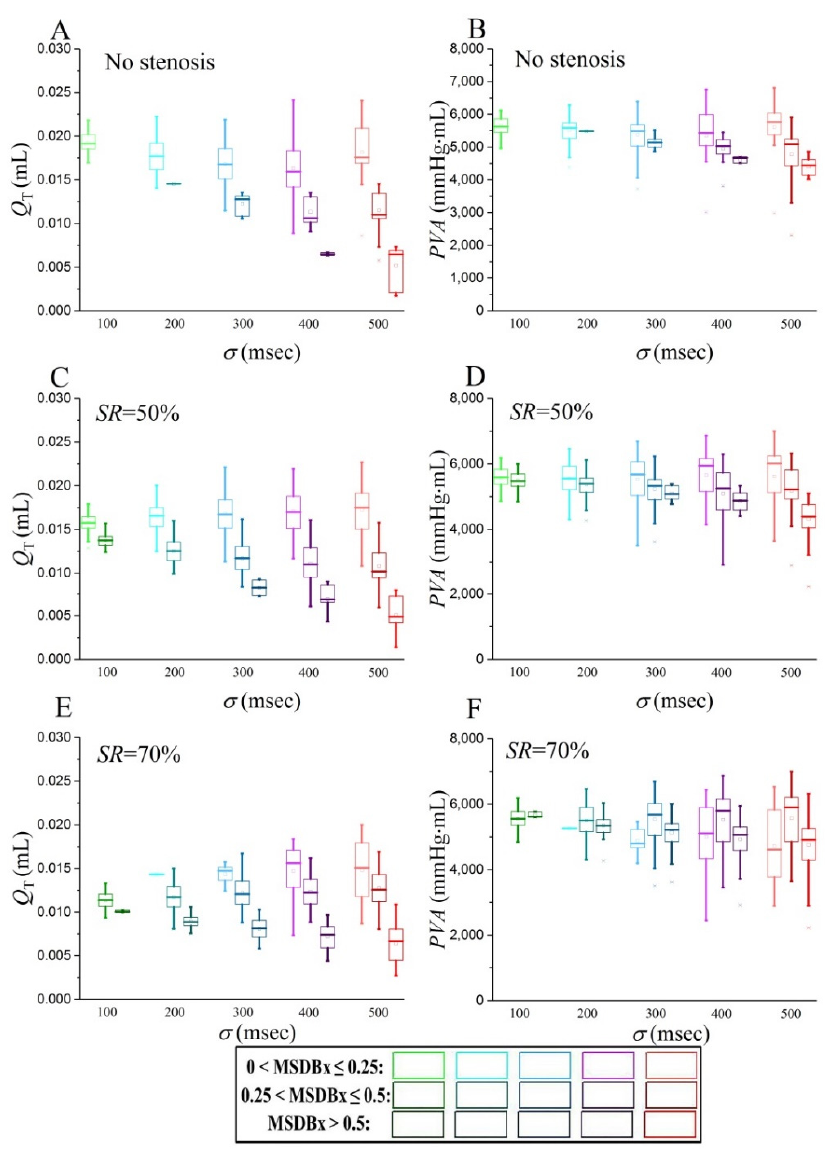
Figure 9. Statistical box plots of cardiac cycle-specific amounts of coronary artery blood flow ( Q T ) ( A , C , E ) and left ventricular PVA s ( B , D , F ) in the groups of cardiac cycles with mild myocardial ischemia (0 < MSDBx ≤ 0.25), moderate myocardial ischemia (0.25 < MSDBx ≤ 0.5) and severe myocardial ischemia (MSDBx > 0.5) within 100 consecutive cardiac cycles with various severities of R-R interval irregularity combined with various severities of coronary artery disease (i.e., no stenosis, SR = 50%, and SR =